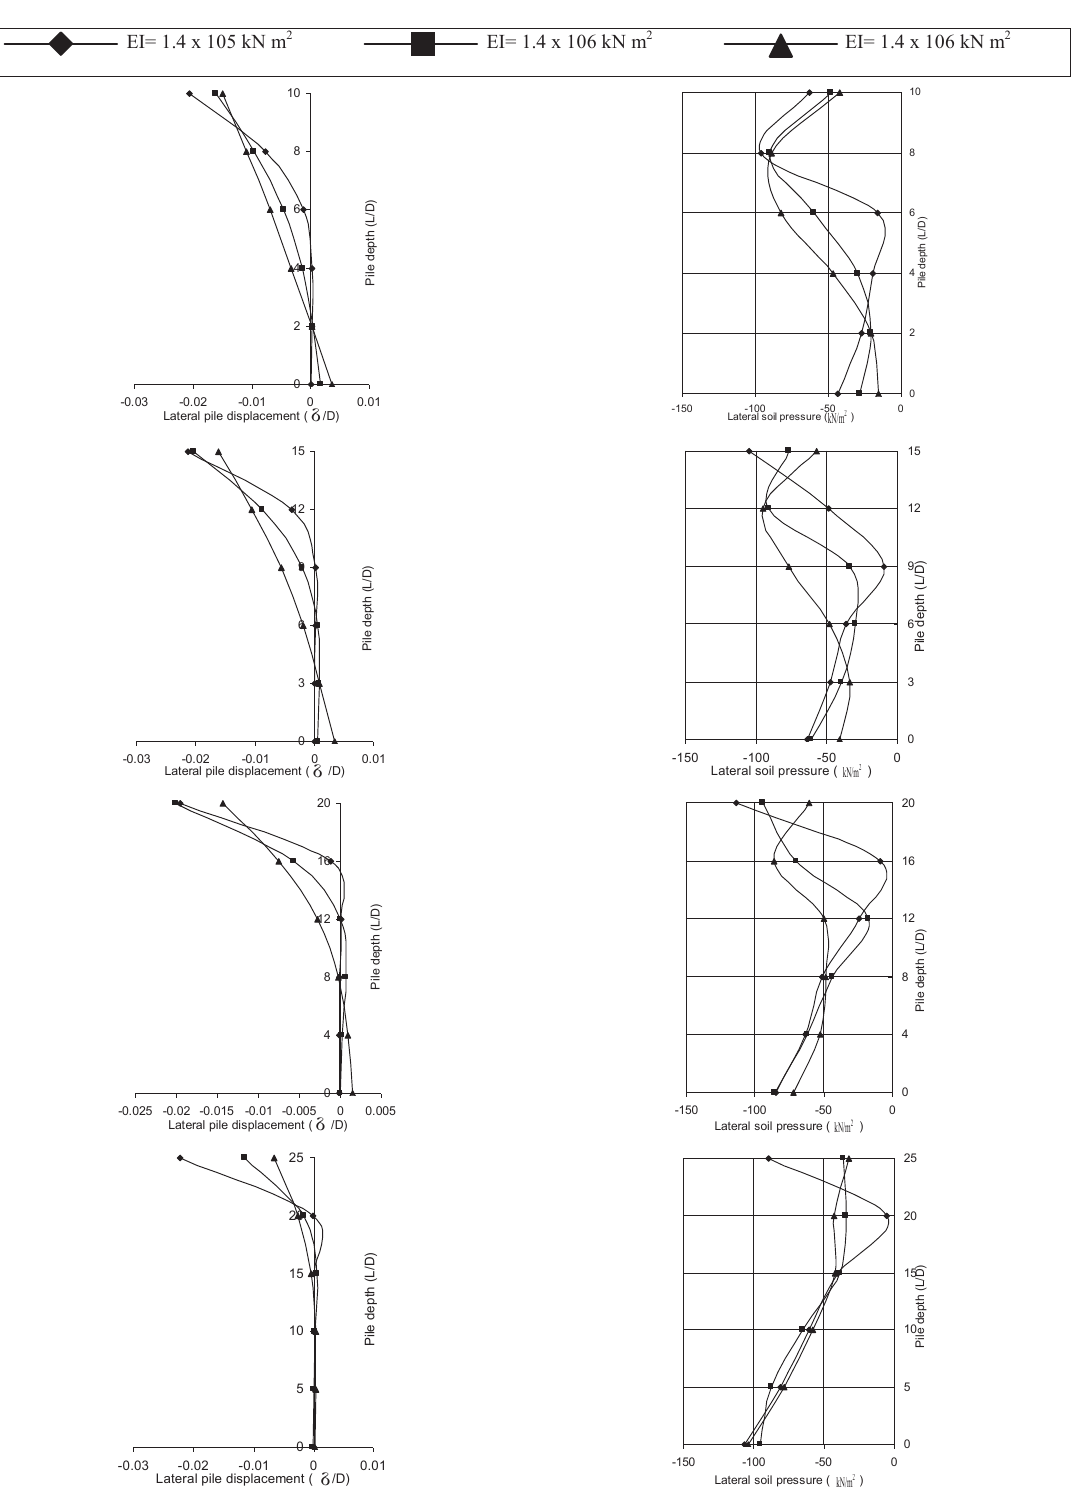
Figure 10 Influence of pile stiffness, EI , on the lateral soil pressure for cohesionless soil, (a) L / D = 10, (b) L / D = 15, (c) L / D = 20 and (d) L / D = 25